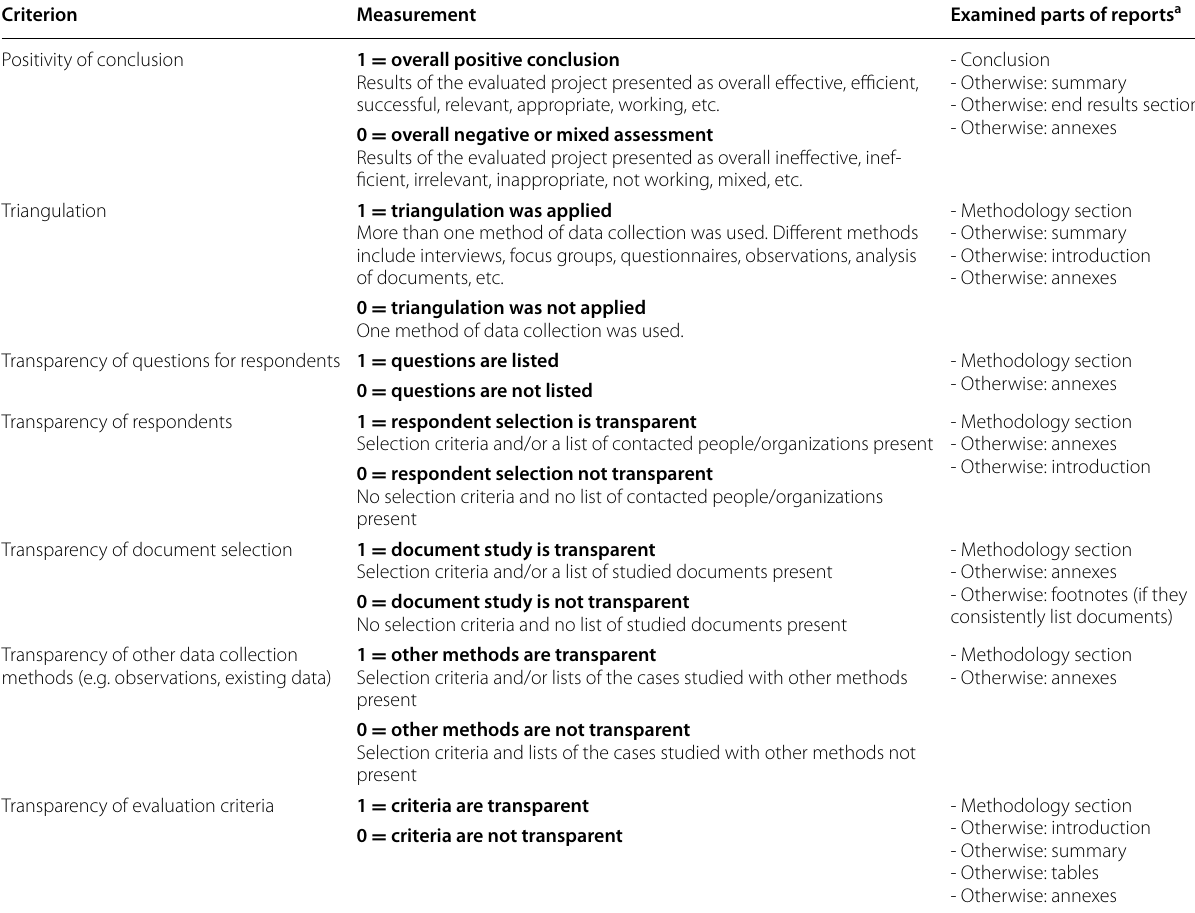
Table 1 Operationalization for document